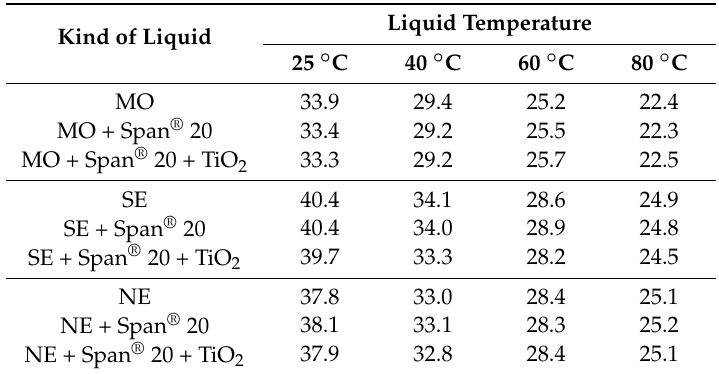
Table 8. Calculation results of temperature decrease in pure electro-insulating liquids and nanofluids based on surfactant Span ® 20 and titanium dioxide (TiO 2